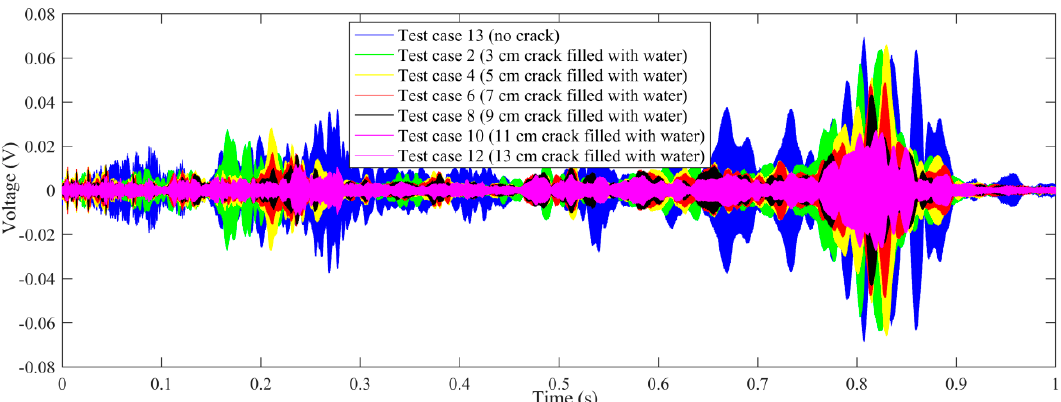
Figure 10. The comparison of voltage signals (test case: no crack and all cracks filled with water).